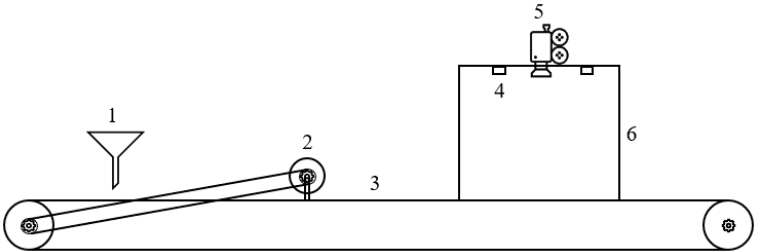
Figure 3. Schematic diagram of the polished rice image acquisition device: 1. hopper; 2. rollers; 3. belt conveyor; 4. toroidal light source; 5. CCD camera; 6. black box.